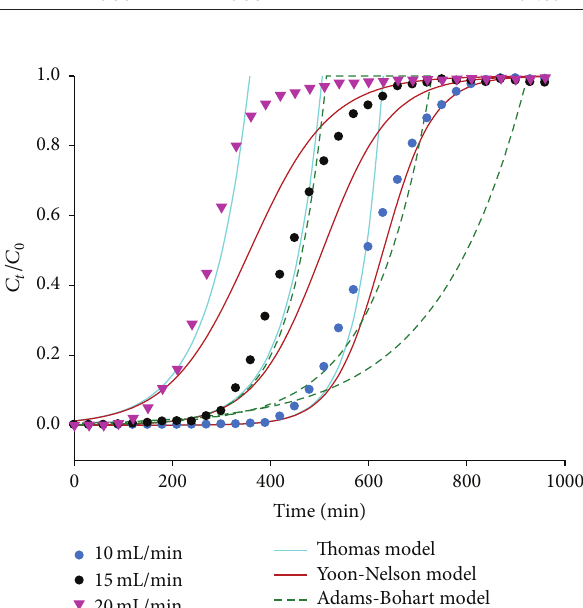
Figure 7: Effect of flow rate on breakthrough curve (concentration 20 mg/L; bed depth 5 cm; pH 5.2).